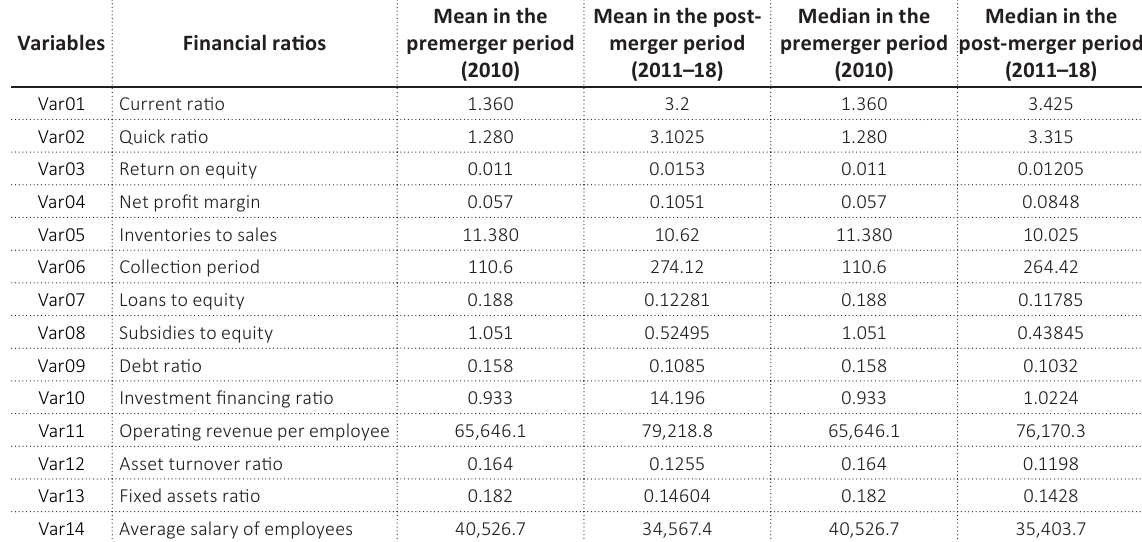
Table 3. Comparison of financial ratios in the pre- and post-merger period